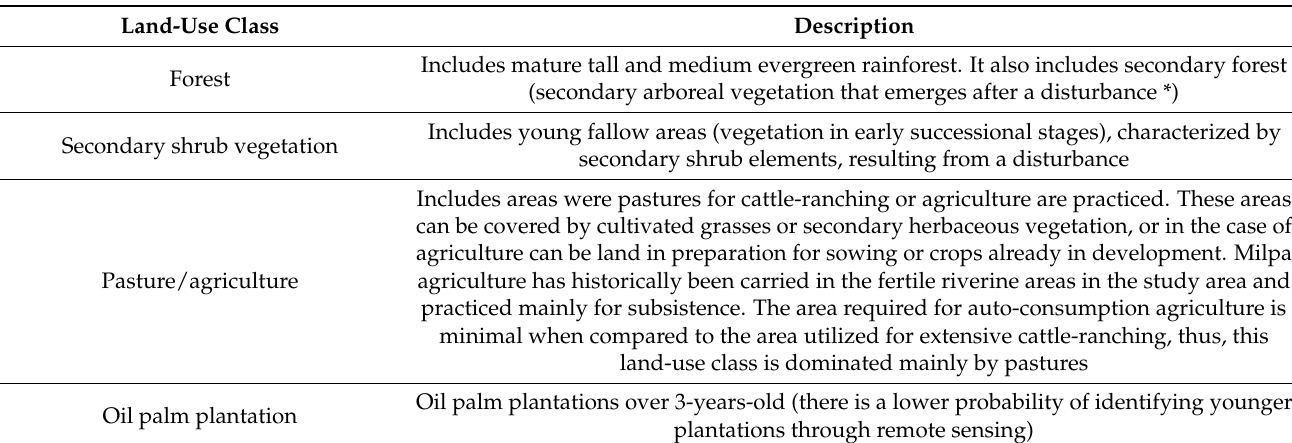
Table 2. Land-use/cover classification of the study